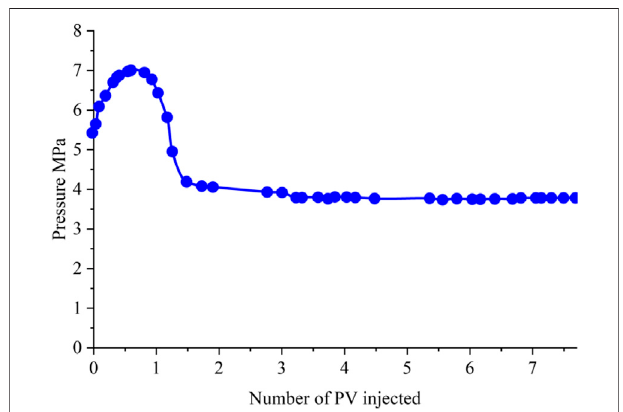
FIGURE 7 | The pressure change of the phantom III.